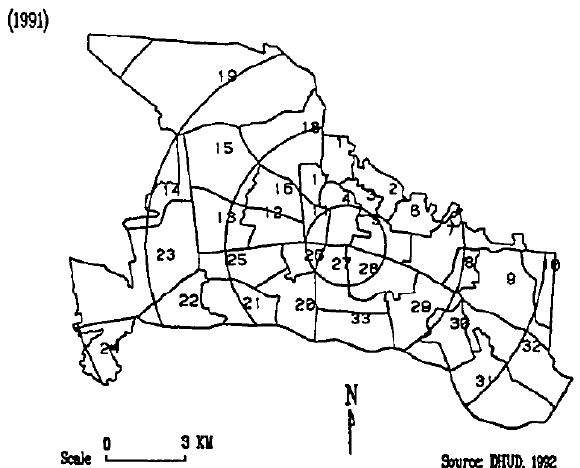
Figure 5. Zone Boundaries in Tabriz (in 1991) (Azimi, 1995, p. 64).